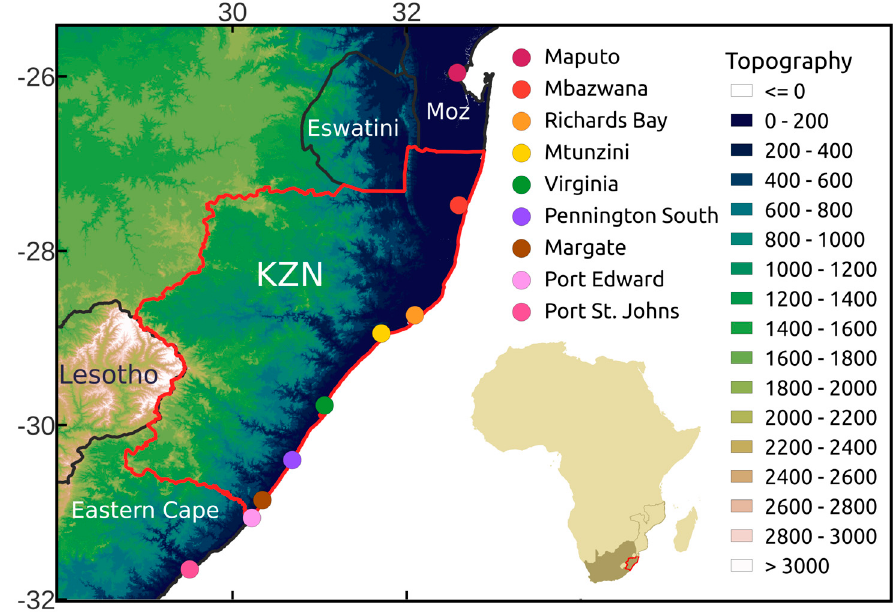
Figure 1. The topography (shaded; m) of the KwaZulu-Natal (KZN) province (red polygon) and surrounding region. The locations referred to in the text are denoted by the coloured circles.